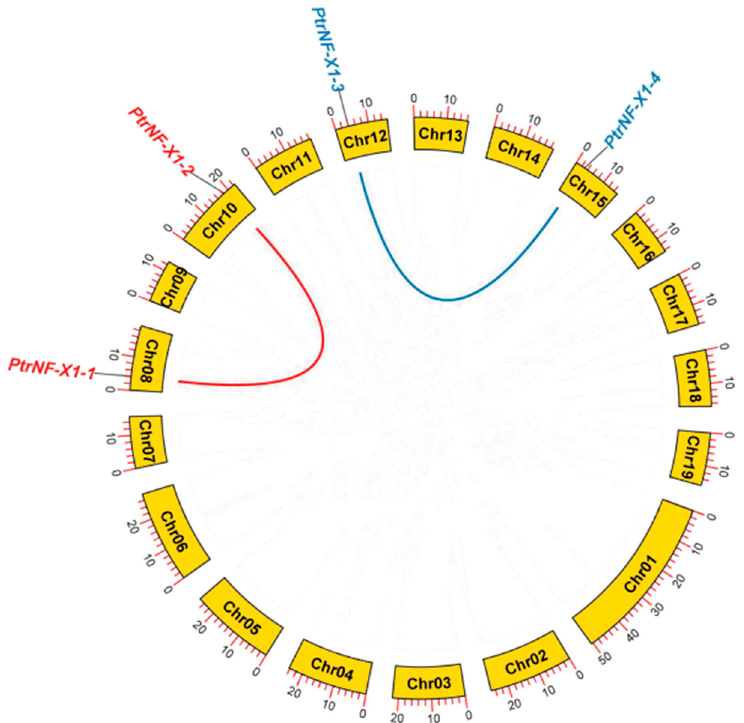
Figure 3. Schematic diagram of NF-X1 gene distribution and inter-chromosomal relationships in P. trichocarpa chromosomes. The gray lines represent all synteny blocks in the chromosome of P. trichocarpa . Red and blue lines show duplicated NF-X1 gene pairs in P. trichocarpa . The chromosome number is shown in the middle of the arc square. The length of each arc corresponds to the length of the chromosome (Mb).